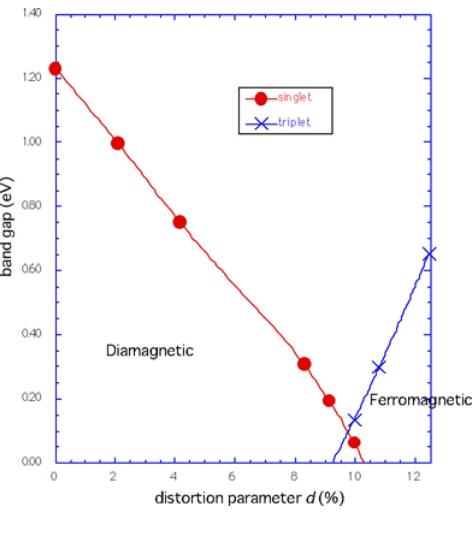
Figure 9. The band gap of Rh -C with increase of distortion parameter d . In case of d = 60 0~9.5%, diamagnetic phase was obtained, while d > 9.5%, ferromagnetic phase was